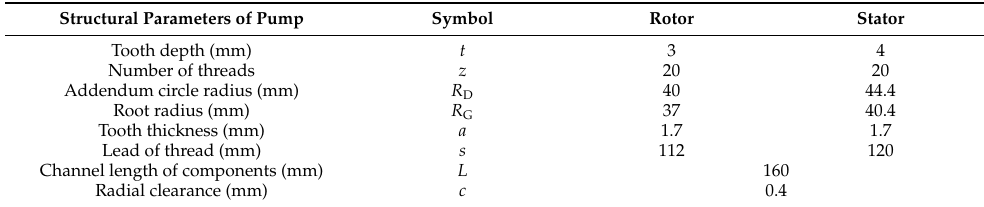
Table 1. Geometric parameters of model